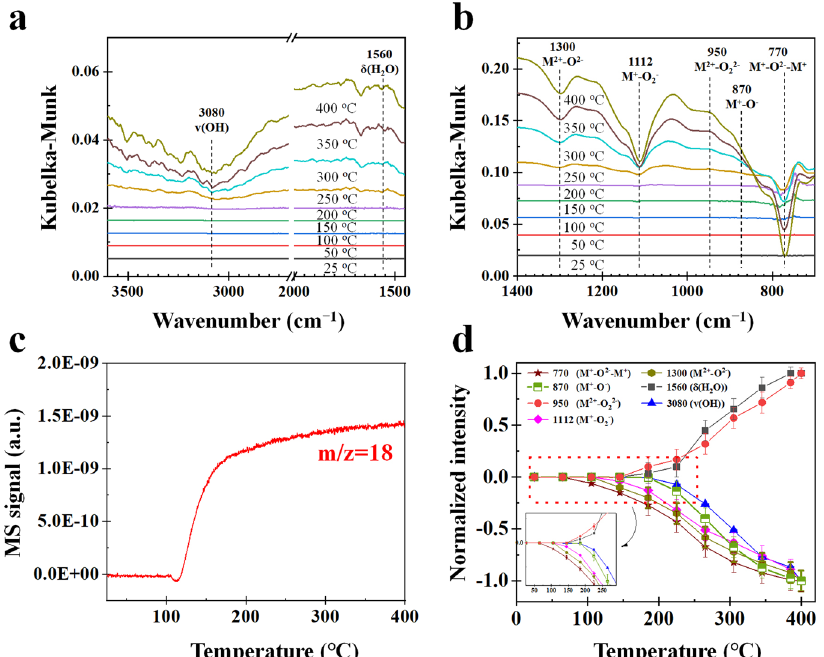
Fig. 2 Experimental results of H 2 oxidation by oxygen species at β -MnO 2 surfaces in H 2 /Ar as a function of temperature. a , b DRIFTS spectra. c MS signal. d Normalized intensities where the error bars are the standard deviations obtained by measuring the peak heights more than three